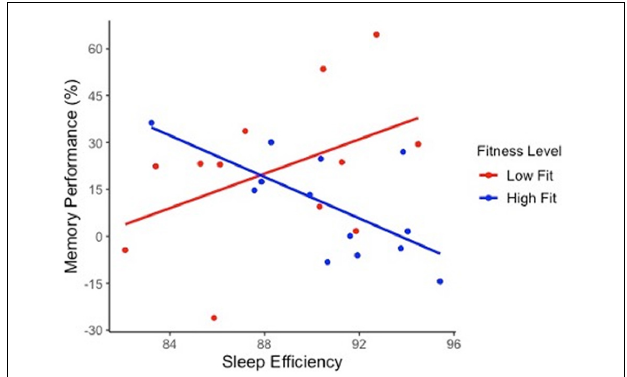
FIGURE 2 | The moderating effect of cardiorespiratory fitness on sleep quality and high-interference memory performance in older adults. Sleep efficiency significantly predict cognitive performance in the lower fit group ( b = 3.77, SE b = 1.65, p = 0.037) but not in higher fit group ( b = –2.81, SE b = 1.71, p = 0.12). Trend lines are not adjusted to